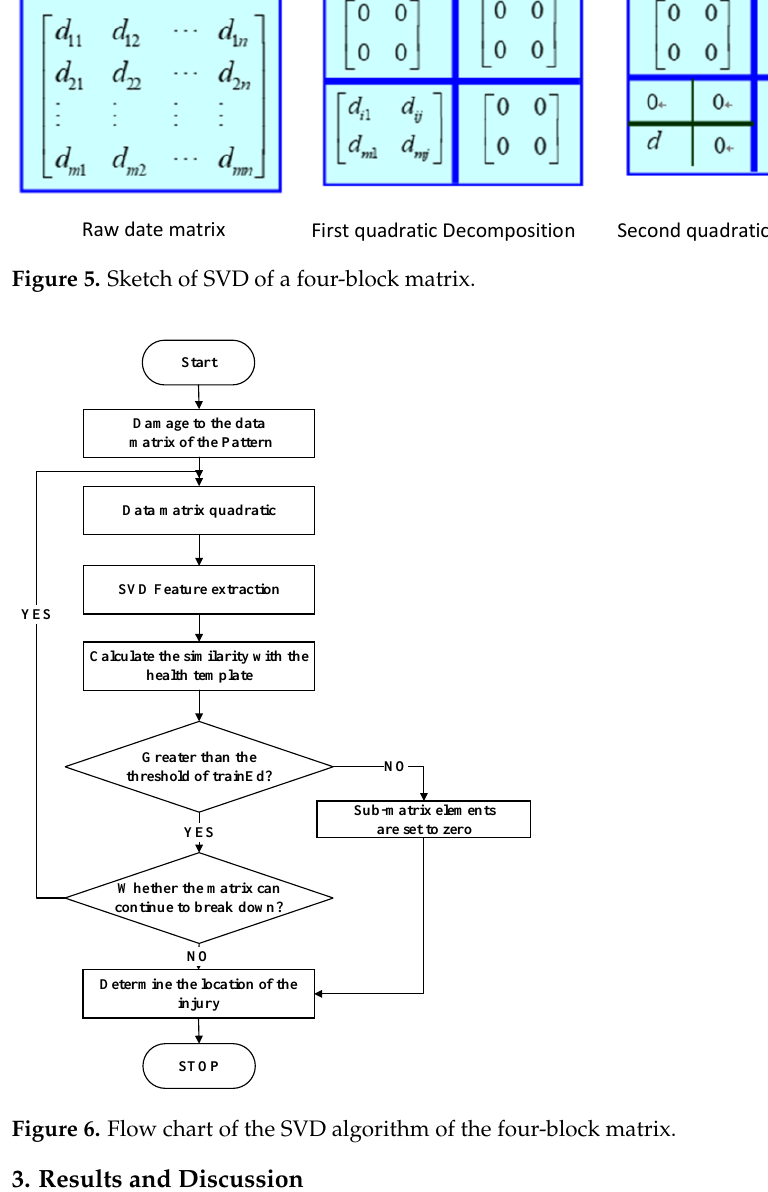
Figure 6. Flow chart of the SVD algorithm of the four-block matrix.